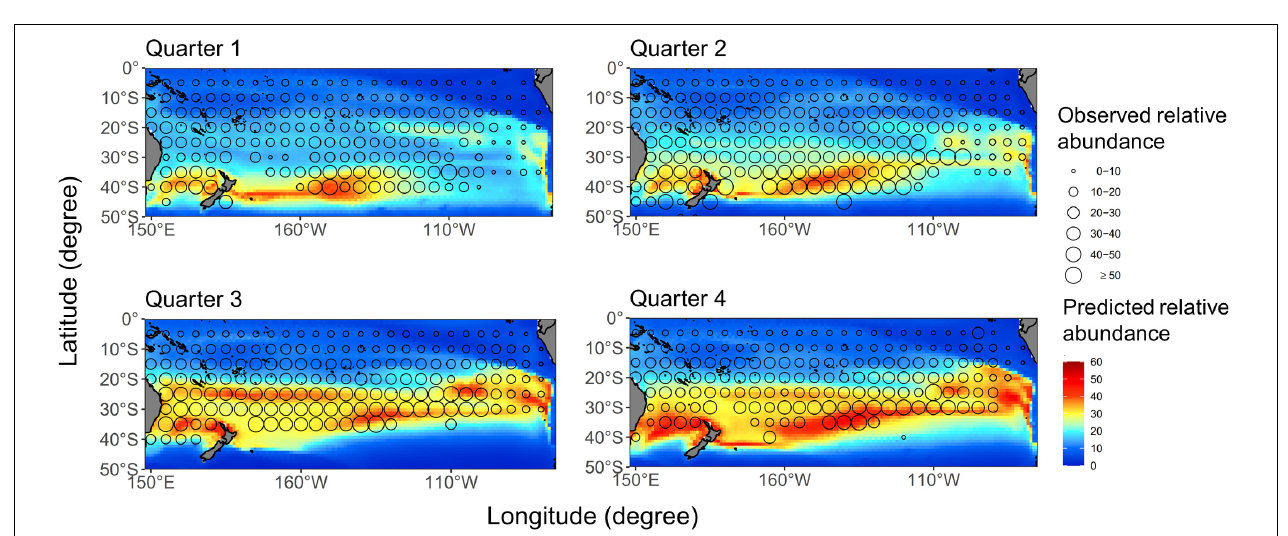
FIGURE 2 | Quarterly average catch-per-unit-effort (CPUE) (number/1,000 hooks) distributions (open circles) for the south Pacific albacore overlaid on the median-ensemble relative abundance map (color contours) based on the GAM which was developed with data from 1997 to 2016.